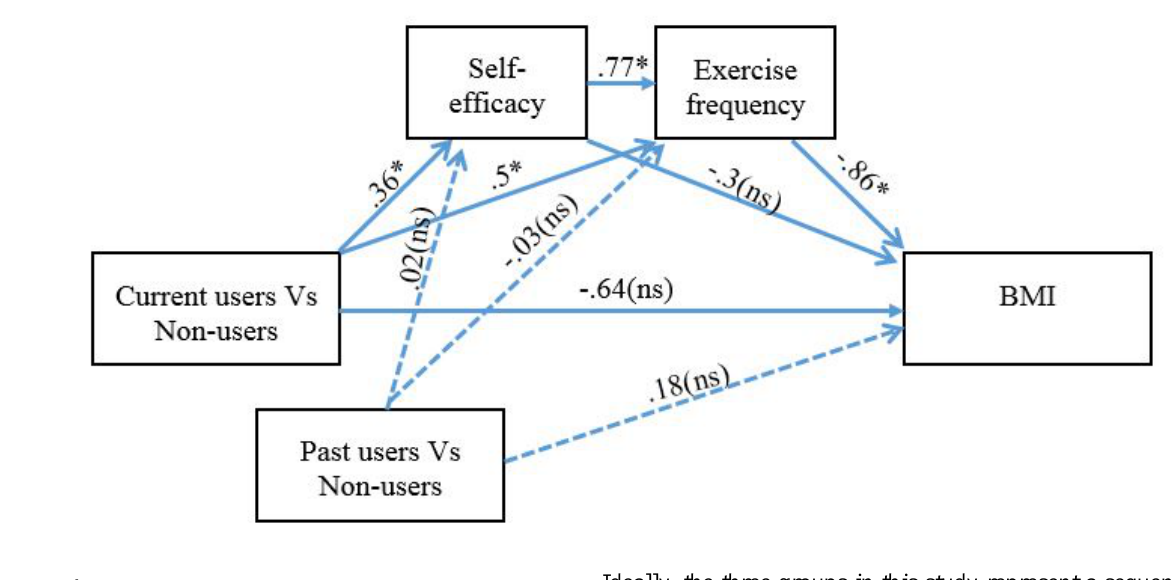
Figure 4. Mediated mediation model in which app use was modeled as a 3-level predictor categorical variable in two separate contrasts. Solid lines depict the indirect and direct effects of a 2-level current users vs non-users contrast’s effect on BMI. The dashed lines depict the indirect and direct effects effect of a 2-level past users vs non-users contrast’s effect on BMI. Asterisk indicates significant results at P <.05 level. ns indicates non-significant results at P <.05